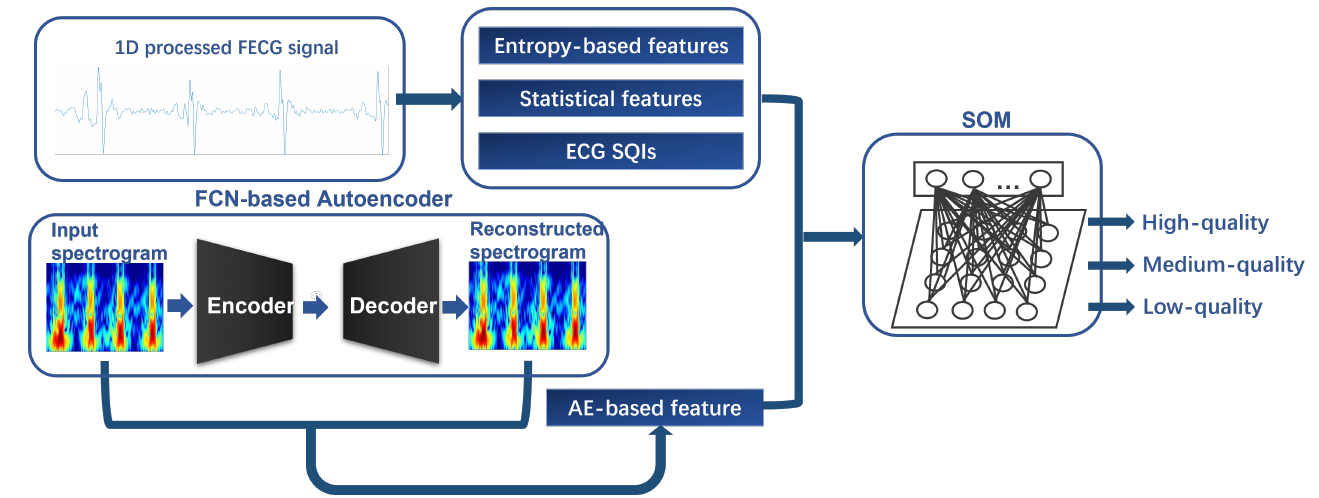
Figure 2. The overall structure of our proposal. The 1D processed FECG signal segments are used to extract entropy-based features, statistical features, and ECG SQIs. Moreover, the 2D spectrograms generated from FECG signals are used to extract an AE-based feature associated with an FCN-based autoencoder. These extracted features are fed into SOM and three quality levels can be